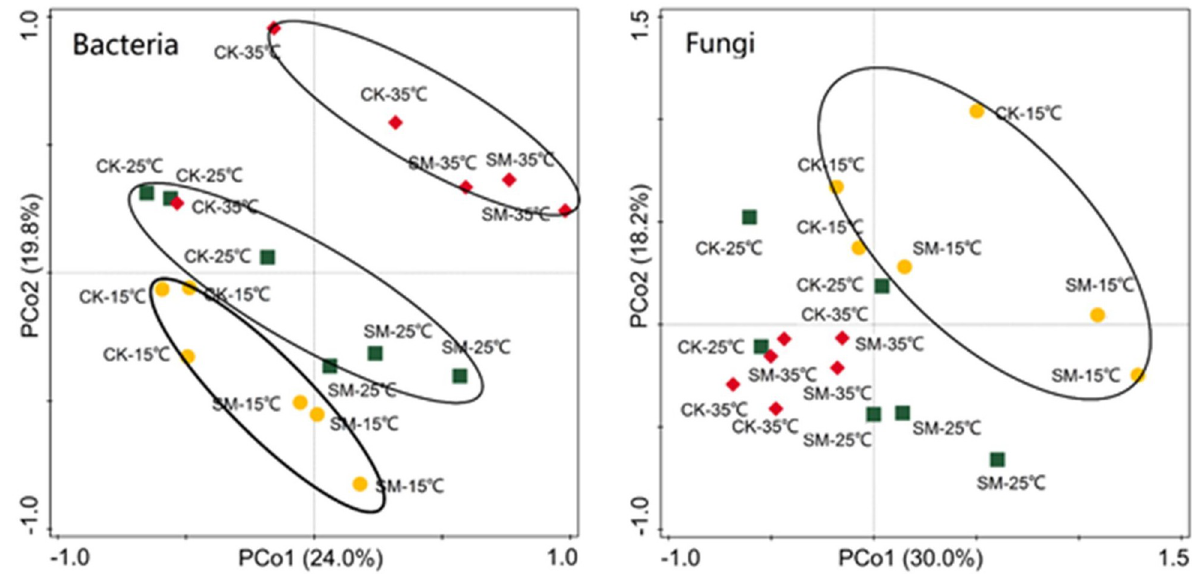
Fig 5. Principal Coordinates Analysis (PCoA) of soil bacterial community composition at different incubation temperatures based on Bray- Curtis distances. CK: no mulching; SM: straw mulching.